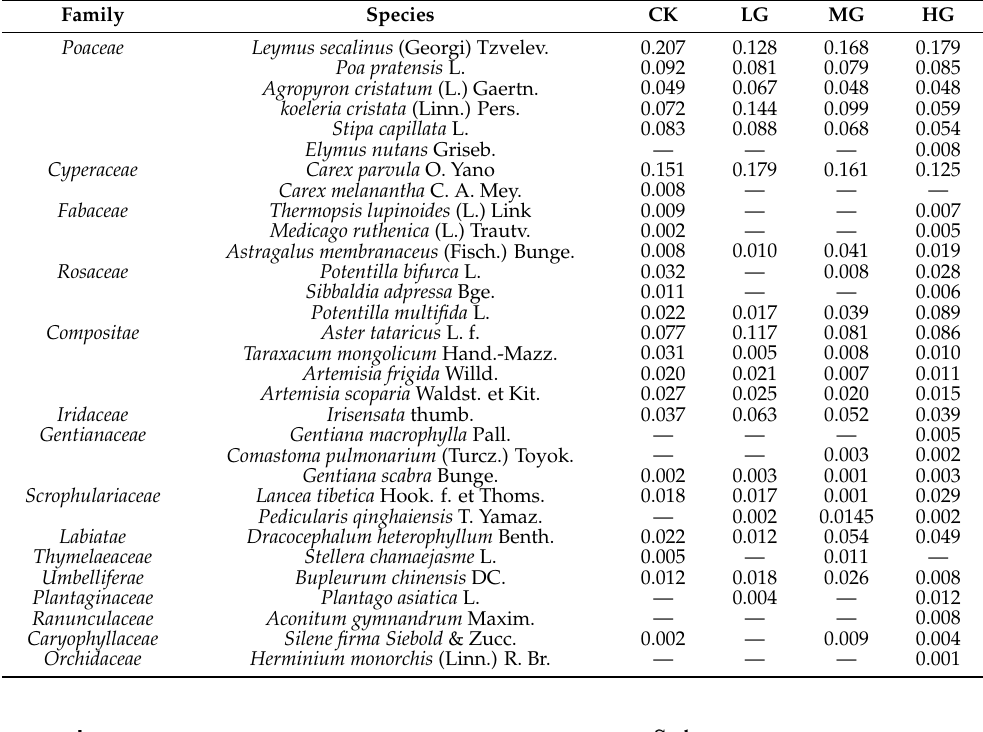
Table 1. Importance value indexes (IV) of species under different grazing intensities.